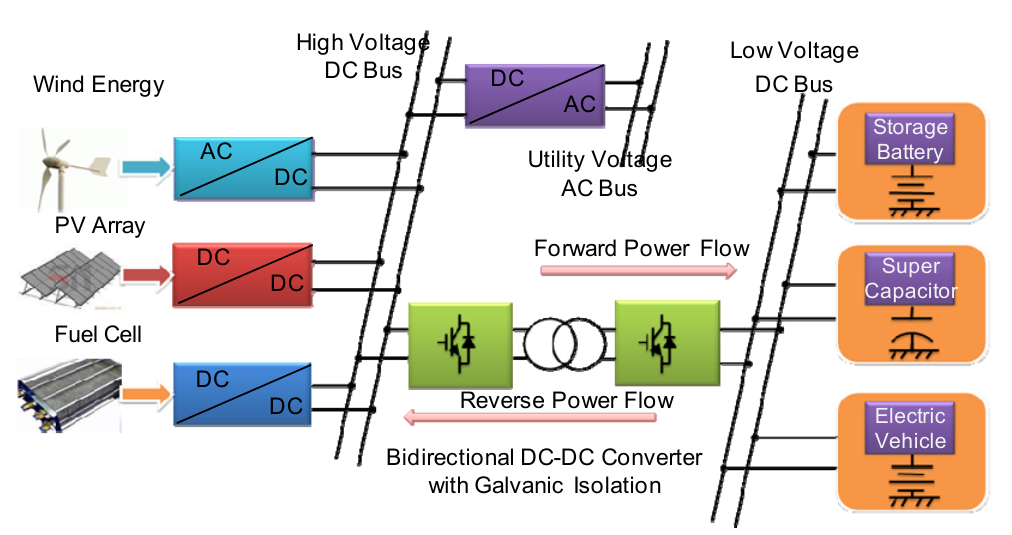
Figure 1. Typical application of IBDC for power distribution in a